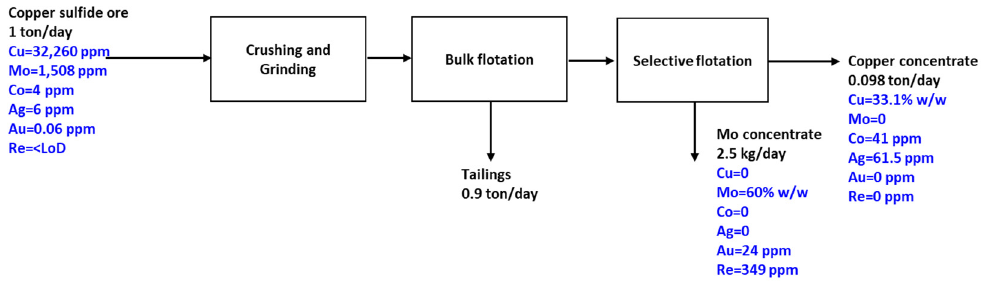
Figure 7. Schematic flow-sheet for a conventional plant design to treat porphyry ores, by processing mine material from the GMU1, to produce copper and molybdenum concentrates.